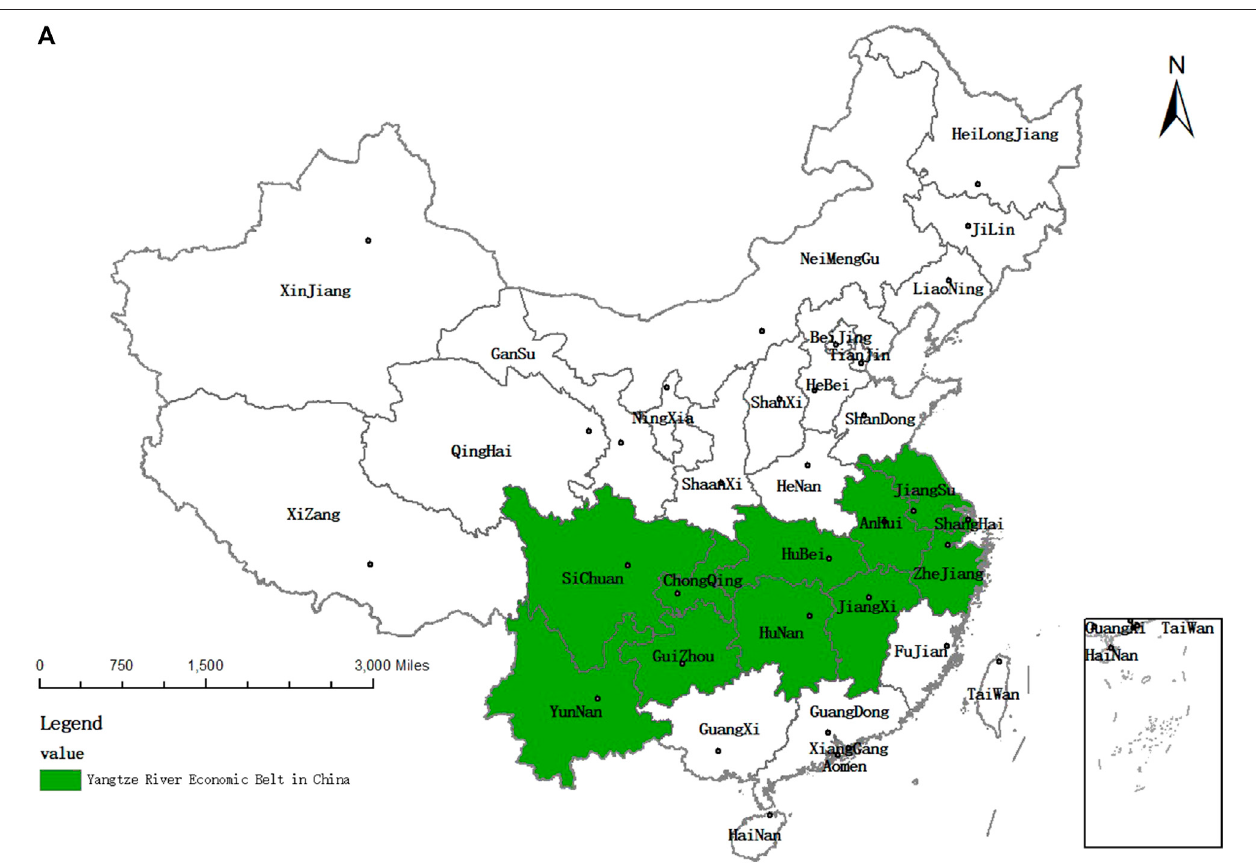
FIGURE 1 | (A) Geographical location of the Yangtze River Economic Belt in China. (B) (2006) Carbon intensity spatial correlation. (C) (2019) Carbon intensity spatial correlation.